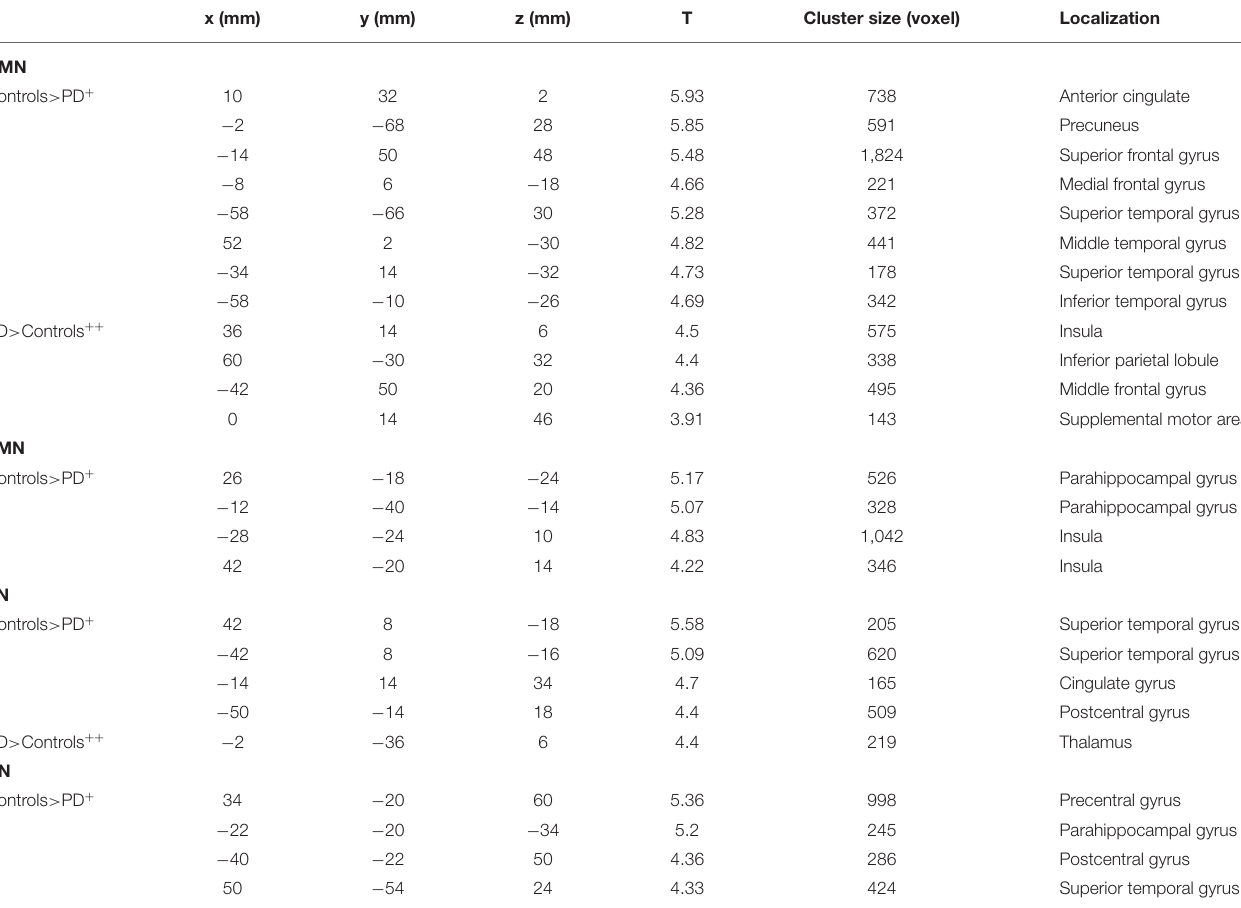
TABLE 3 | Brain regions with significant connectivity differences between PD and controls of selected functional networks. x (mm) y (mm) z (mm) Cluster size (voxel)